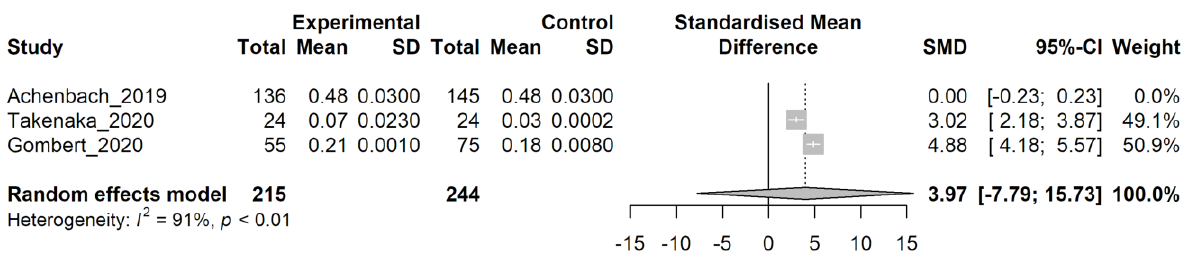
Figure 4. Random effect model analysis of group 1 papers, excluding Achenbach et al., 2019. Study: